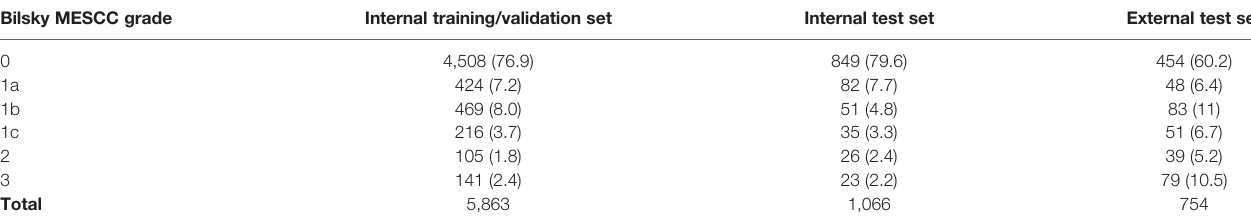
TABLE 2 | Reference standards for the internal (training and test) and external (test) sets showing the number of Bilsky MESCC grades.